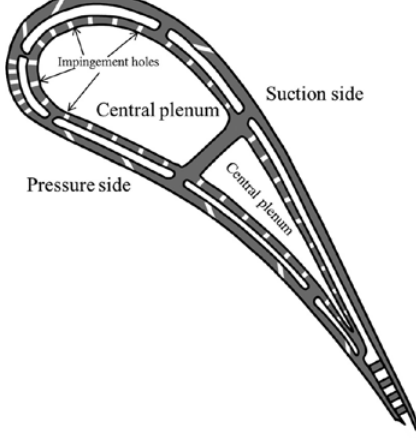
Figure 1. Double wall cooling vane from [16].